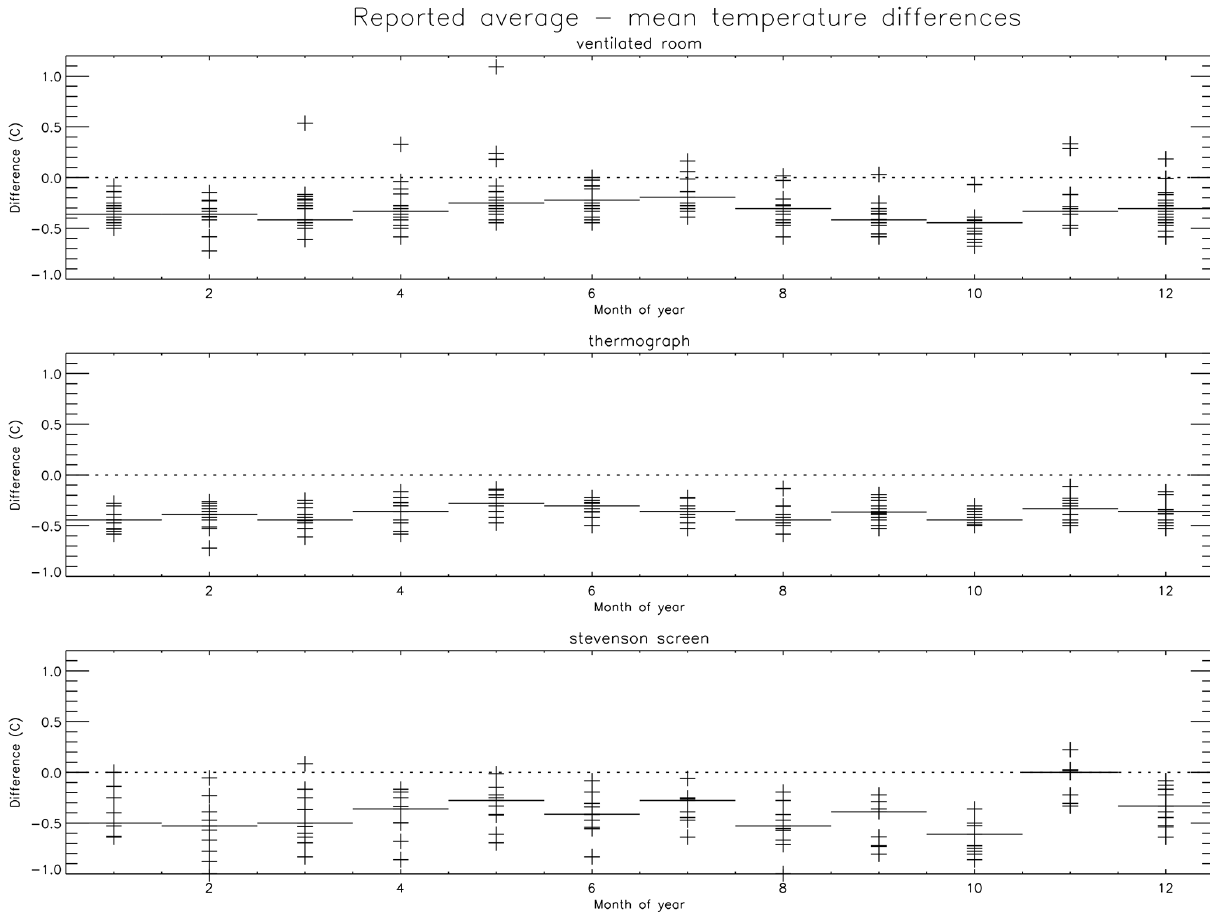
Figure 19. As Fig. 12 but for the differences between reported average and mean temperatures for each individual instrument configuration. All axis ranges are identical to aid